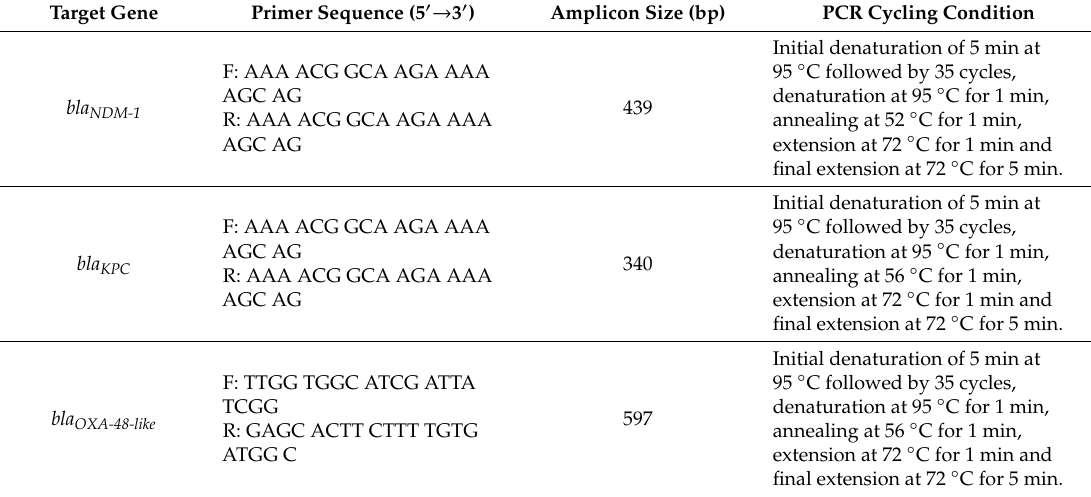
Table 2. List of primers for screening of carbapenem resistance genes